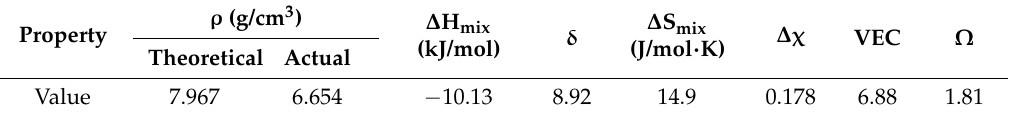
Table 2. Thermodynamic data calculated for the AlAgCuNiSnTi equimolar alloy.